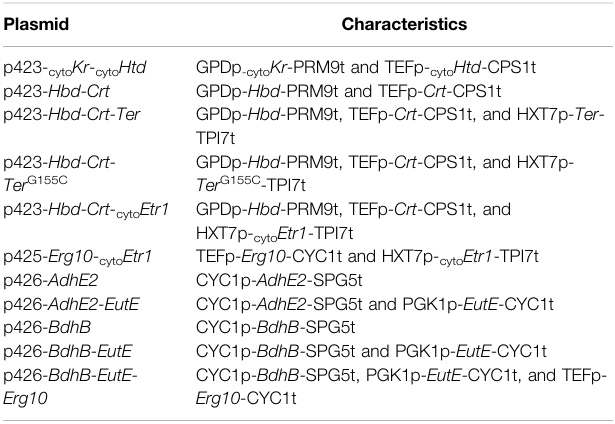
TABLE 2 | Plasmids used in this